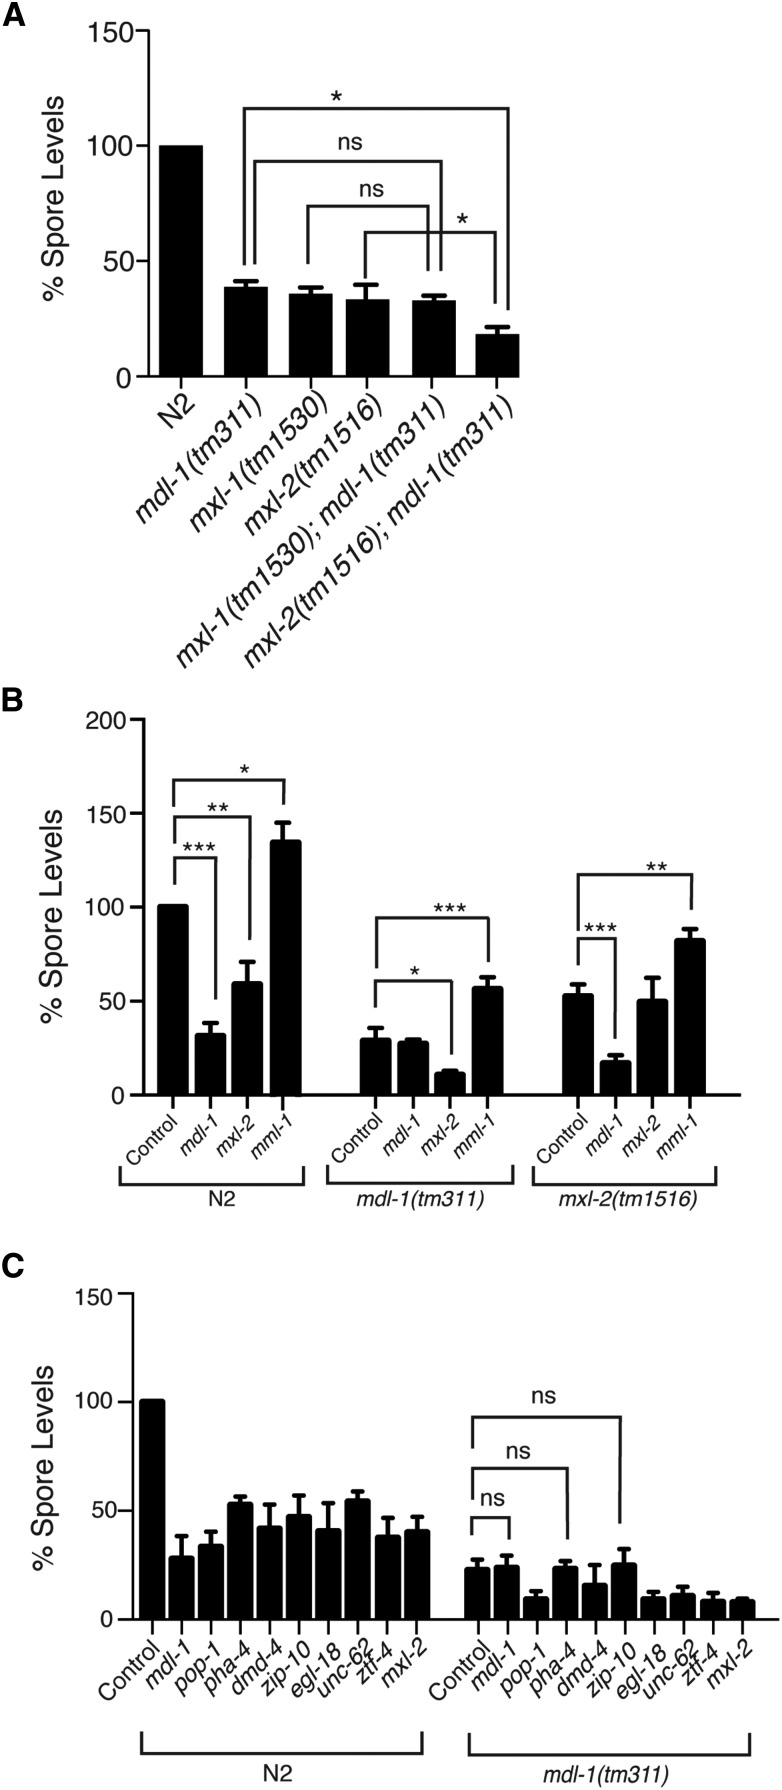
Epistasis analysis of MDL-1, MXL-1, MML-1, and MXL-2 shows noncanonical activity of this pathway during infection. (A) Spore levels at 40 hpi were quantified in N2, mdl-1(tm311), mxl-1(tm1530), mxl-2(tm1516), mxl-1(tm1530);mdl-1(tm311), and mxl-2(tm1516);mdl-1(tm311) C. elegans. Spore levels are the mean of three independent experiments, normalized to N2. Error bars are SEM. (B) Spore level values for N2, mdl-1(tm311) and mxl-2(tm1516) mutants treated with RNAi to knockdown mdl-1, mxl-2, or mml-1. Animal genotypes are denoted by brackets, and each column shows either empty vector control (L4440) or RNAi treatment. (C) Spore levels for N2 and mdl-1(tm311) animals treated with RNAi against all other transcription factor library hits (all comparisons with empty RNAi vector control found to be significant except for the three marked “ns”). Error bars represent the SEM for three independent experiments consisting of three replicates per experiment. ns, not significant. * P < 0.05, ** P < 0.01, *** P < 0.001.